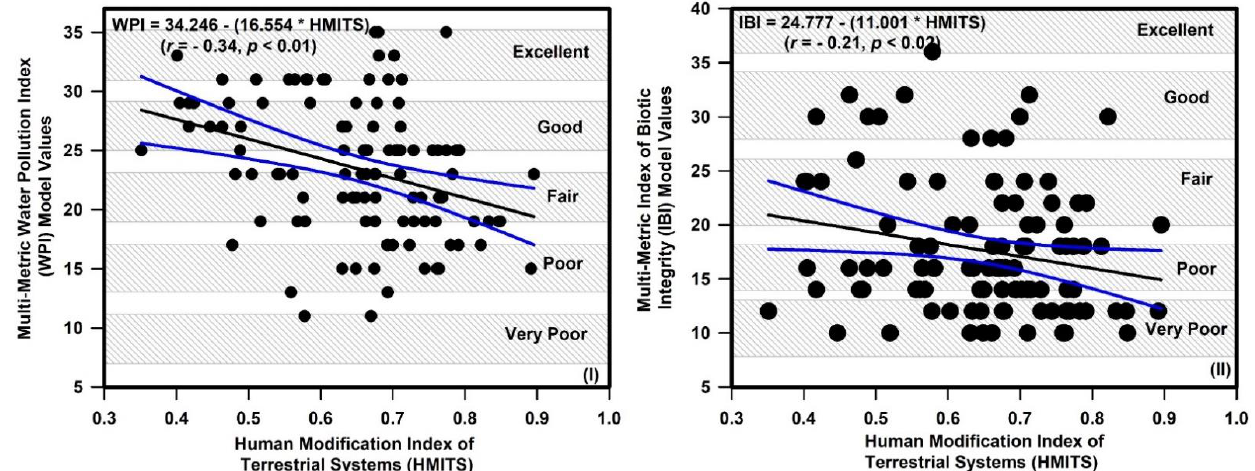
Figure 8. Relations of human modification index of terrestrial systems (HMITS) with chemical and biological health in the Nakdong River basin. ( I ) Influence of HMITS on the multi-metric water pollution index (WPI) model and ( II ) influence of HMITS on the index of biotic integrity (IBI) model.